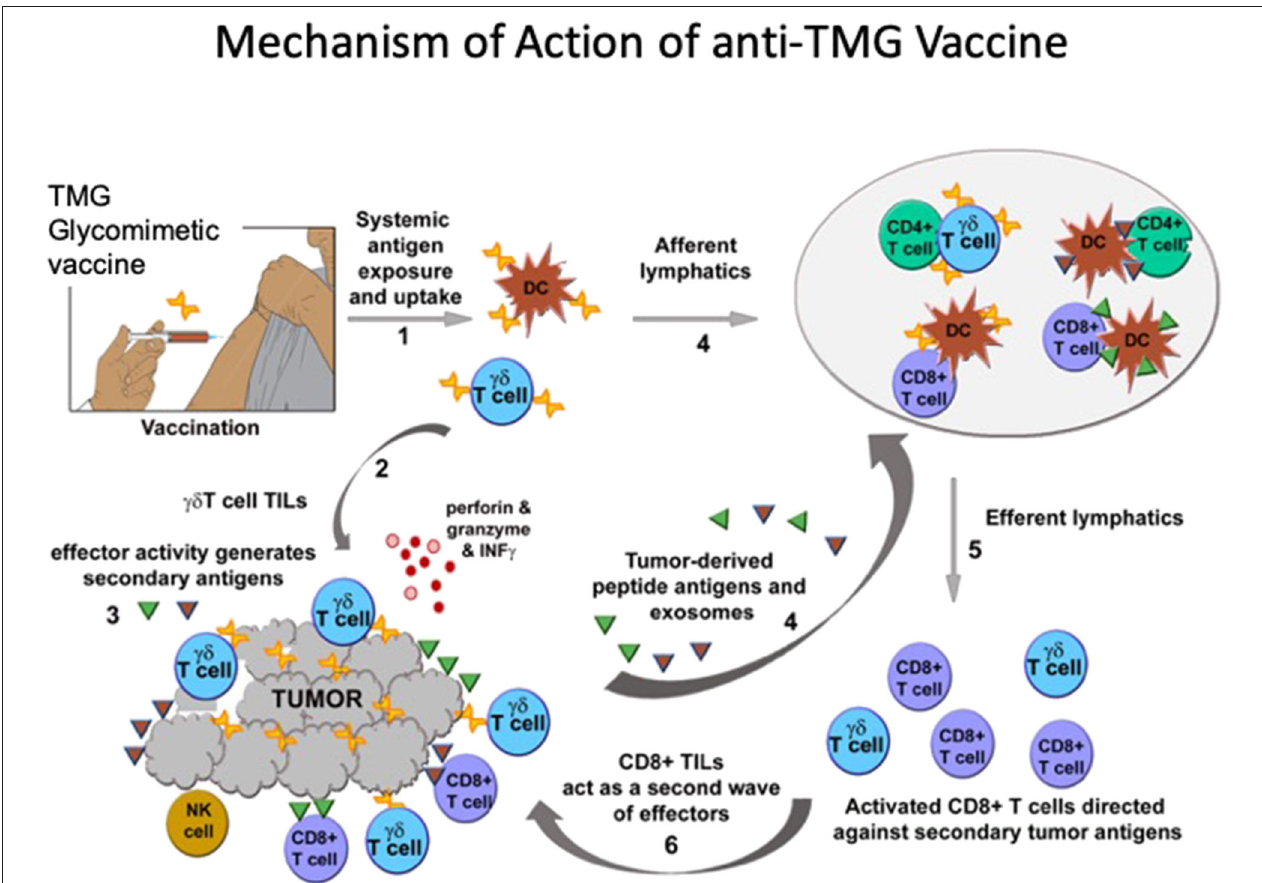
FIGURE 1 | TMG glycomimetic vaccine mechanisms of immune activation. After systemic delivery of the vaccine antigens, (1) there is a rapid expansion of γδ T cells. It is unknown whether γδ TCRs expand by binding directly to the vaccine glycomimetic product, or whether the antigen is presented by DCs. Expansion of γδ T cells is independent of whether mice bear tumors expressing TMGs, so while the vaccine may also block the immune-suppressive action of TMGs upon T cells this mechanism is unlikely to account for the initial expansion. (2) In mice bearing TMG-expressing tumors, vaccination affords a significant increase in γδ T cells TILs. (3) The effector activity generates secondary antigens or neoantigens. (4) Putative neoantigens (not yet identified) circulate and are presented to CD8 + αβ T cells which (5, 6) expand as a second wave mainly comprising CD8 + T cells that also become TILs. The generation of in vivo T-cell memory in glycomimetic vaccines was not evaluated. However, anti-TMG humoral immunity (evaluated as a surrogate marker) matures and class-switches from IgM to IgG.